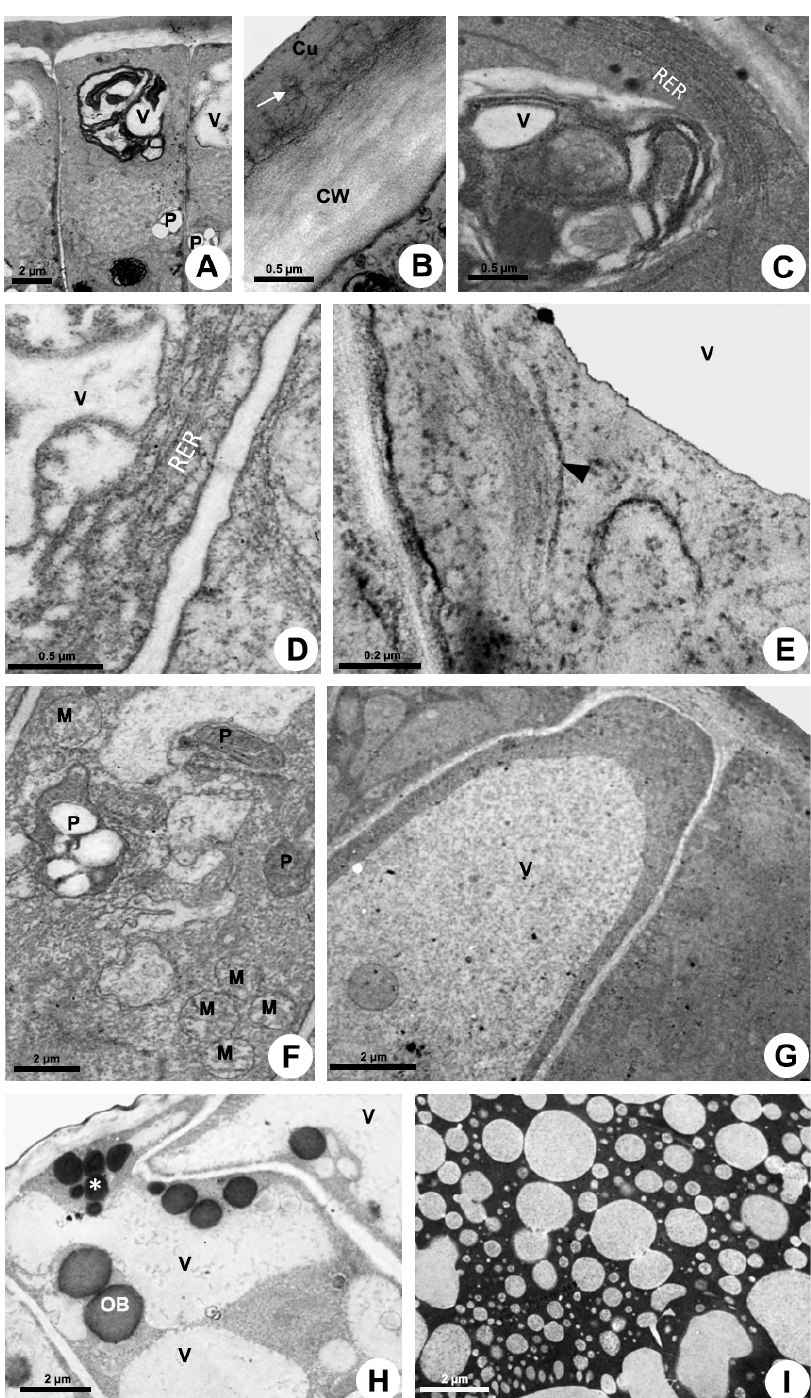
Figure 5. Ultrastructure of the colleter secretory cells of Blepharodon bicuspidatum ( A – B , D – F , H ) and Allamanda shottii ( C , G , I ). Transmission electron microscopy. ( A , C ) Vacuoles with heterogenous content. ( B ) Pectin projections from the cell wall (CW) into the cuticle (Cu). ( D ) RER in parietal position. ( E ) Dictyosome vesicles being directed to the plasma membrane. ( F ) Plastids with starch grains and mitochondria. ( G ) Central vacuole filled with secretion. ( H ) Vesicles with polysaccharides detected using PATAg test (asterisk) and oil bodies (OB). ( I ) Detection of lipids with imidazole- osmium tetroxide test in the secretion on the colleter. Arrow = pectin projections within cuticle; Arrowhead = dictyosome; M = mitochondrion; P = plastid; RER = rough endoplasmic reticulum; V =